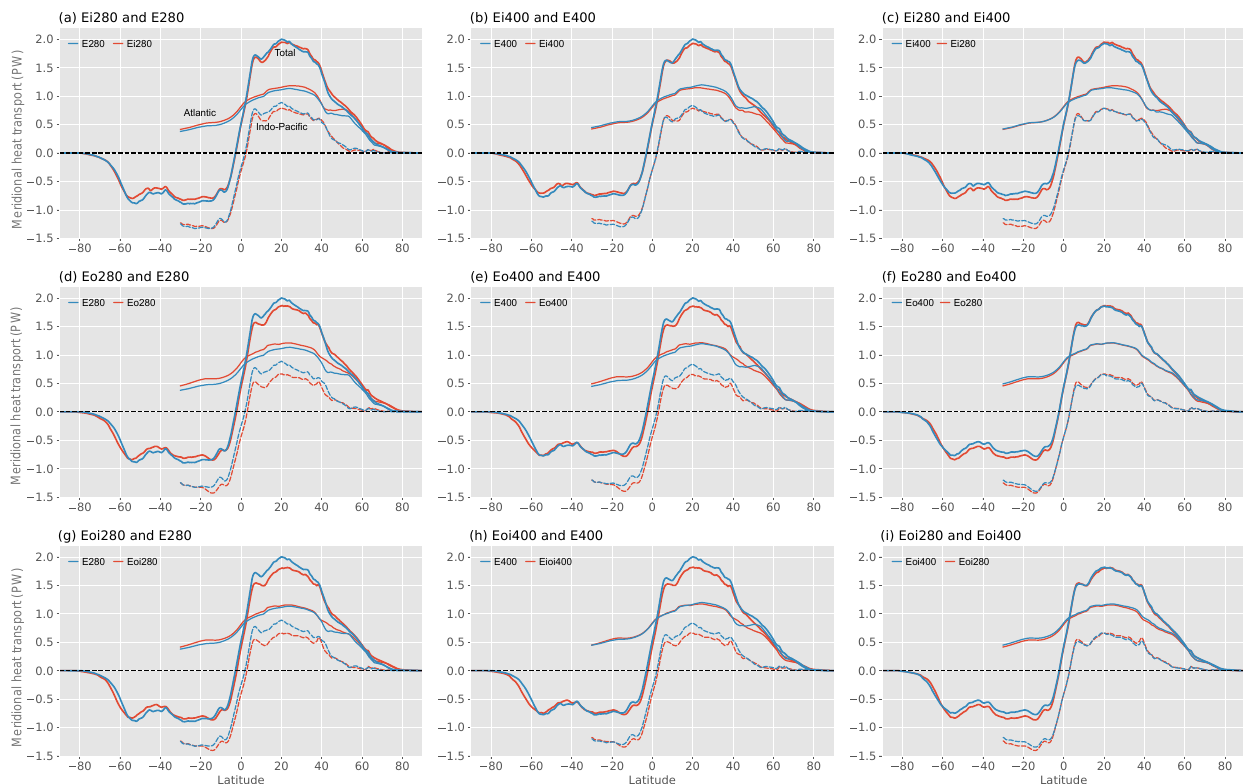
Figure 14. Various comparisons of the climatological total meridional heat transport by the ocean and the individual transports in the Atlantic and the Indo-Pacific basins. The total oceanic heat transport curves are the same curves that are labeled “Ocean” and shown in Fig. 13. The climatology years are noted in Table